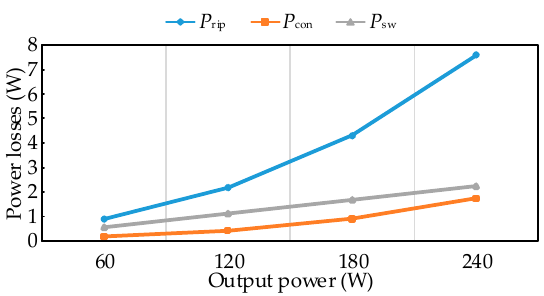
Figure 23. The variations of the three types of losses.